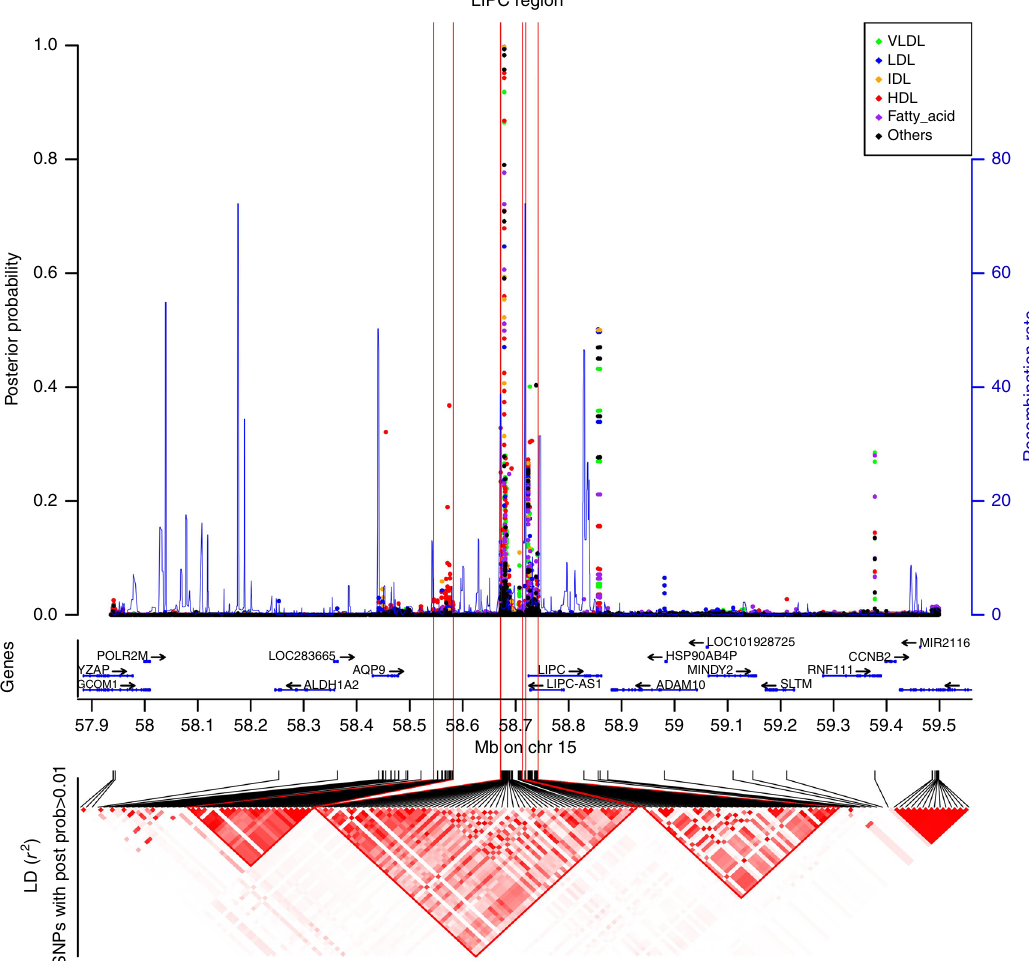
Fig. 5 Fine mapping of the LIPC region. The top panel indicates the posterior probability assessing the evidence that the SNP is causal for each of the 75 phenotypes and the local recombination rate. The middle panel contains genes from the UCSC hg19 annotation. The lower panel is a r ²-based LD heatmap computed using PLINK1.9 on the METSIM data. The gradient of red is proportional to the r ². For clarity, we represented the LD only for SNPs with a posterior probability > 0.01 for at least 1